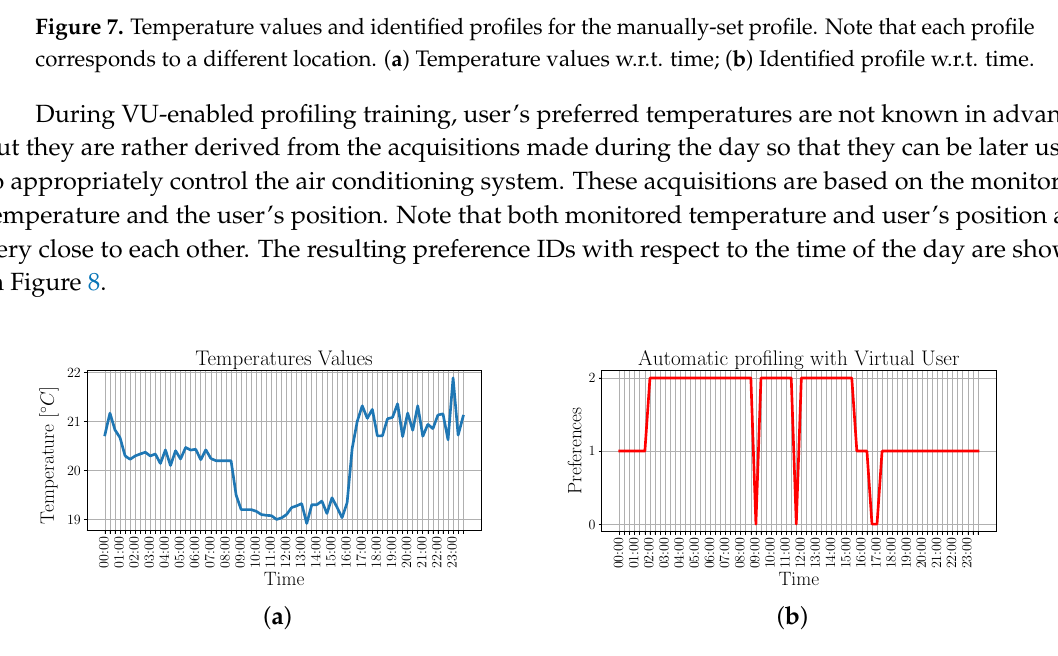
Figure 8. Temperature values and identified profiles for the VU-enabled automatic profiling. ( a ) Temperature values w.r.t. time; ( b ) Identified profile w.r.t. time.